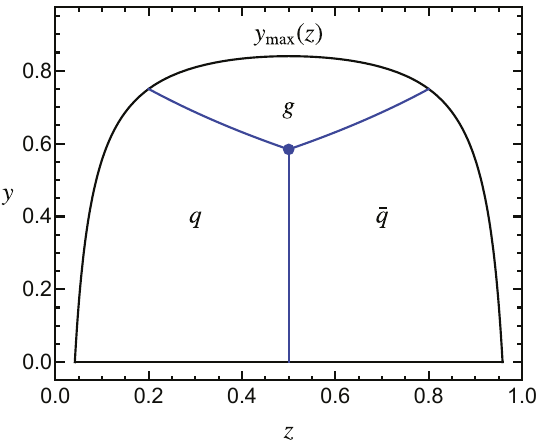
Figure 5 . Phase space diagram in ( z; y ) coordinates for two particles with equal mass (quark and anti-quark) and a massless particle (gluon). The plot is generated with the numerical value m=Q = 0 : 2. The available phase space is contained between the y = 0 and y = y max ( z ) curves, which intersect at the points ( z = z (cid:6) ; y = 0). Blue lines split the phase space into regions where the thrust axis points into the direction of the quark, anti-quark or gluon momenta. The three lines meet at the point (1 = 2 ; y middle ), marked by a blue